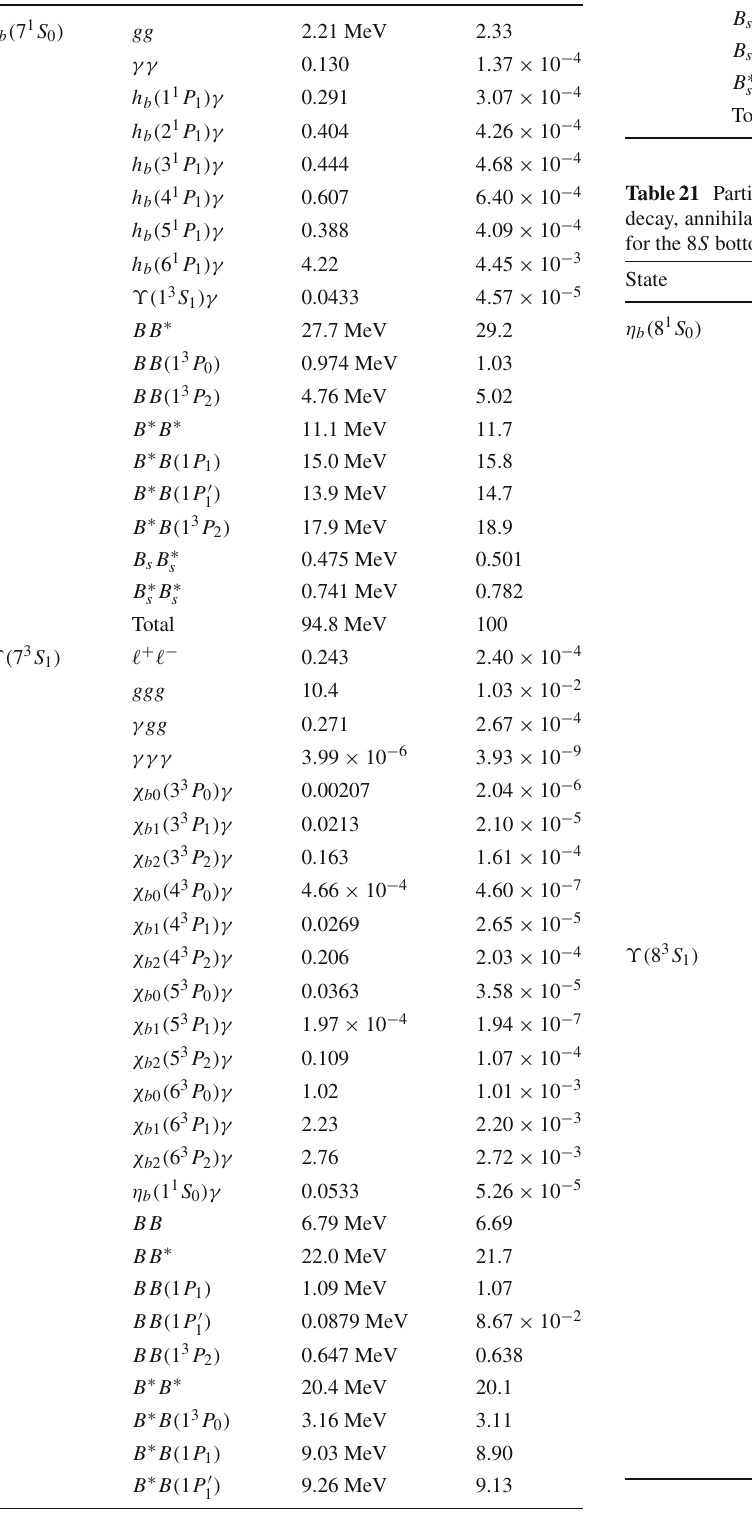
Table20 PartialwidthsandbranchingratiosoftheOZI-allowedstrong decay, annihilation decay, and radiative transition and the total widths for the 7 S bottomonium states. The width results are in units of keV